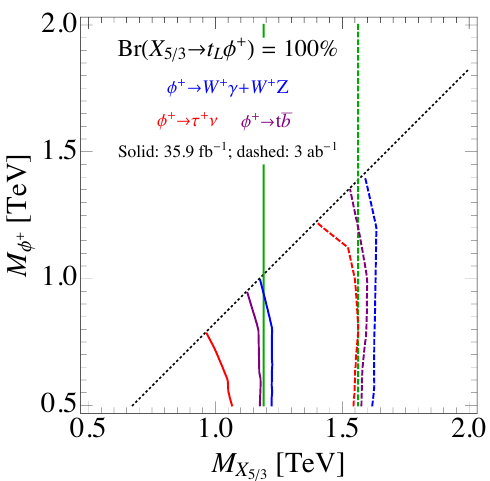
Figure 3 . Bounds on the M X projections for the HL-LHC reach (dashed lines) for the various (cid:30) + decay modes (blue-red-purple). The black dotted line indicates M X kinematically unaccessible. The bounds and projections for the standard Br( X decay are shown for reference in green lines. The bounds become insensitive to M above